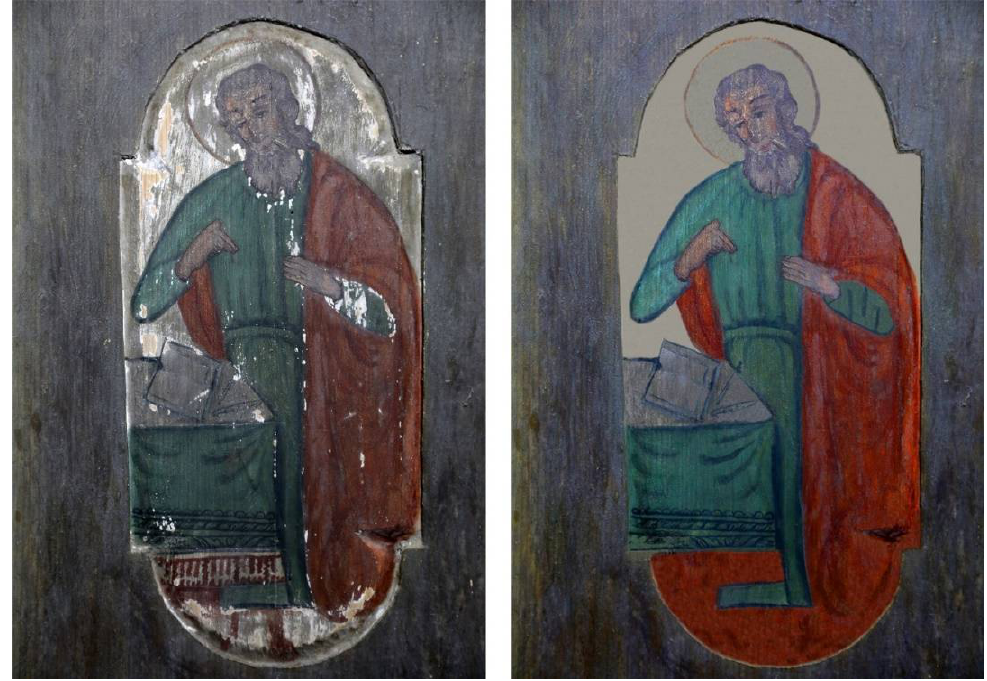
Figure 16. Proposed digital restoration of Saint Marc illustration on the imperial gates from Voivodeni.